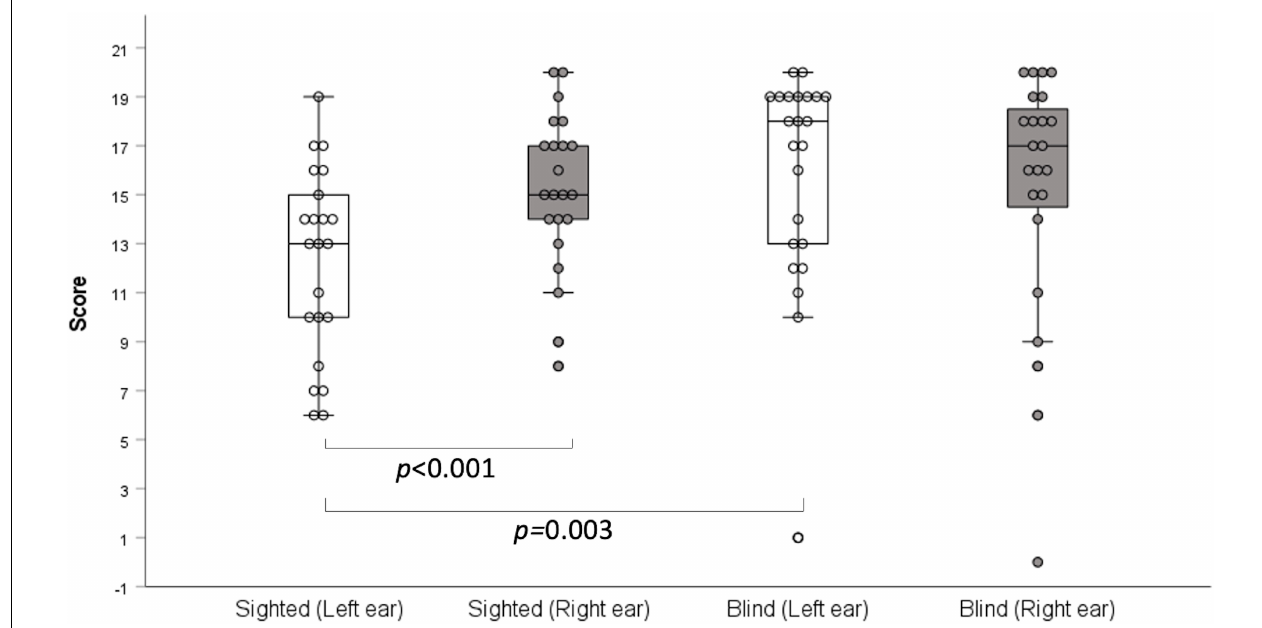
FIGURE 1 | Dichotic three-digit test. Early-blind subjects had higher scores than the sighted subjects in the left ears ( p = 0.003), but not in the right ears. A right-ear advantage was detected in the sighted subjects ( p < 0.001), but not the early-blind subjects.